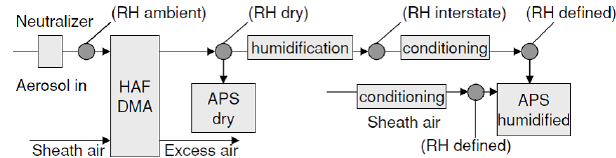
Figure 23. Schematic diagram of a H-DMA-APS apparatus. Reprint with permission by Kaaden et al. (2009). Copyright 2009 Blackwell Munksgaard.